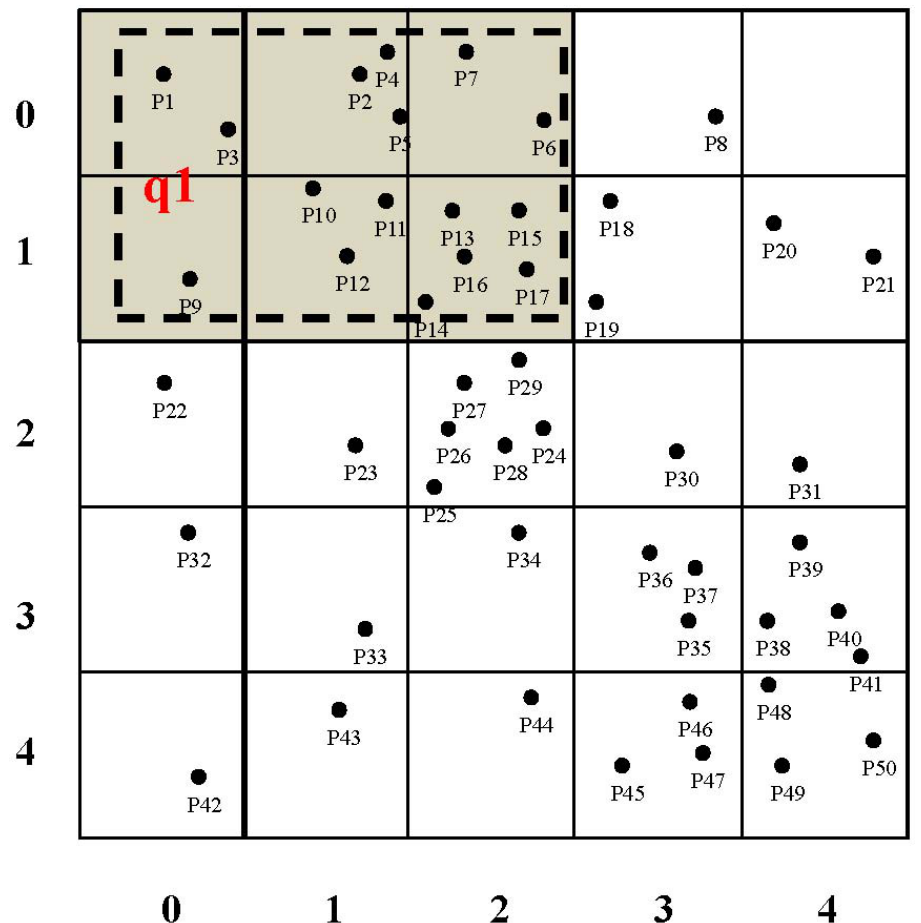
Figure 2. An example of grid division, where 50 sensor nodes are deployed unevenly in the network region and several kinds of attributes are assumed sensed by these sensor